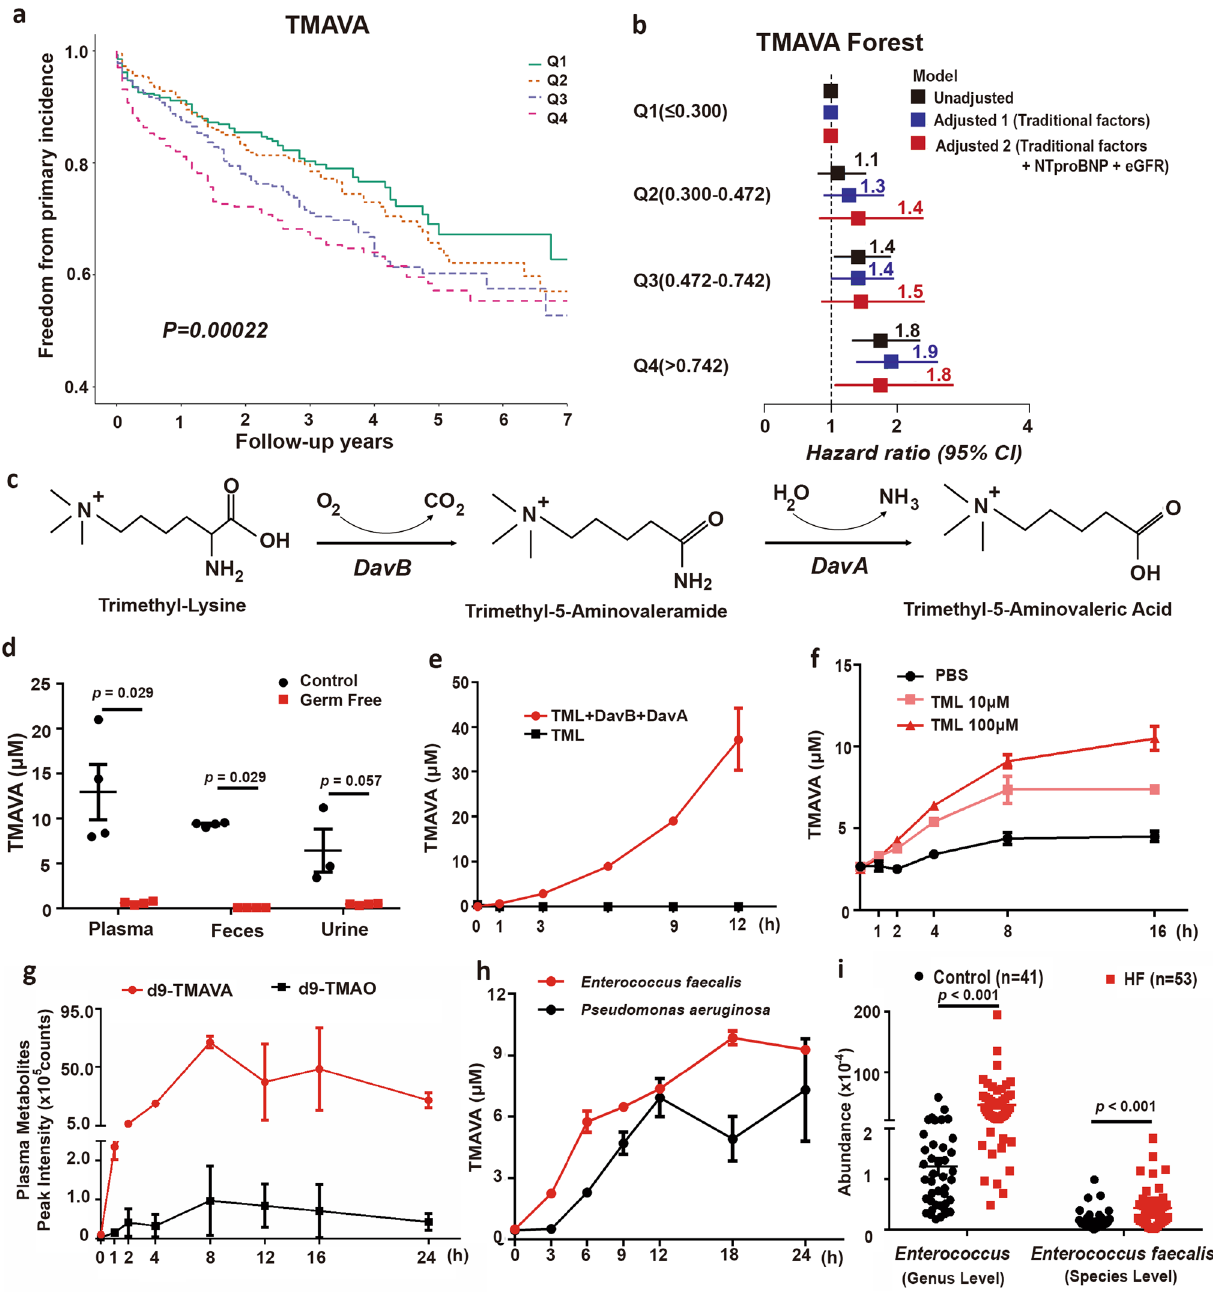
Fig. 1 Elevated plasma TMAVA level is associated with incident cardiac death and transplantation risk, independent of traditional risk factors. a Kaplan – Meier estimate of 7-year risk for cardiac death and transplantation ranked by TMAVA quartiles in the cohort ( N = 1647). b Forest plots indicate the HR (95% CI) for incident (7-year) risk for cardiac death and transplantation according to TMAVA quartiles. HR (unadjusted, black squares) and multivariate Cox model 1 adjusted (blue squares; adjusted for age, sex, smoking, SBP, diabetes, high-density lipoprotein [HDL], low-density lipoprotein [LDL]), or model 2 adjusted (red squares, adjusted for model 1 plus eGFR and NTproBNP). The 95% con fi dence interval is indicated by the line length. HR hazard ratio. c Schema for the production of TMAVA from TML by the DavB and DavA coupled system. d TMAVA levels were signi fi cantly lower in plasma, feces, and urine of germ-free mice ( n = 4). e Production of TMAVA from TML by the DavB and DavA coupled system in vitro ( n = 3). f Feces from conventionally raised mice were co-incubated with different TML concentrations and TMAVA levels were measured ( n = 3). g Mice were challenged with d9-TML. Post-challenge measurement of d9-TMAVA and d9-TMAO was performed in serial venous blood draws at the indicated times by stable isotope dilution LC – MS ( n = 2). h Enterococcus faecalis and Pseudomonas aeruginosa were co-incubated with 1 mM TML and TMAVA levels were measured at the indicated time points ( n = 2 and 3). i Abundance (percentage of the whole microbiota) of Enterococcus at the genus level and E. faecalis at the species level were analyzed in patients using metagenomics sequencing. Statistical signi fi cance was evaluated by a two-tailed nonparametric Mann – Whitney test [( d ) and ( i )]. (* P < 0.05, ** P < 0.01, *** P < 0.001). Data are expressed as mean ± SEM. Source data are provided as a Source Data fi le.